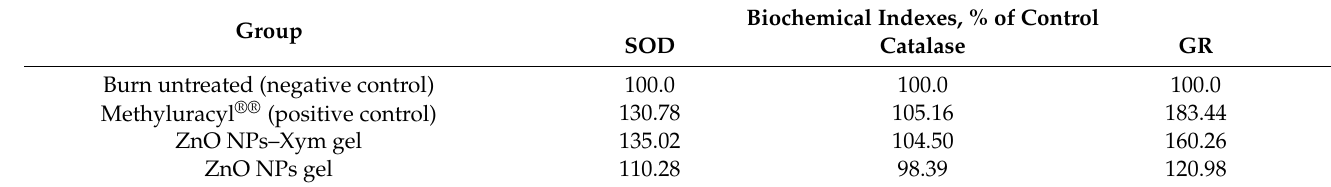
Table 8. Specific activity of SOD, catalase, and GR on the rat blood on the 10th day after thermal burn under the treatment by dosage forms, in % of control ( n = 3, p <